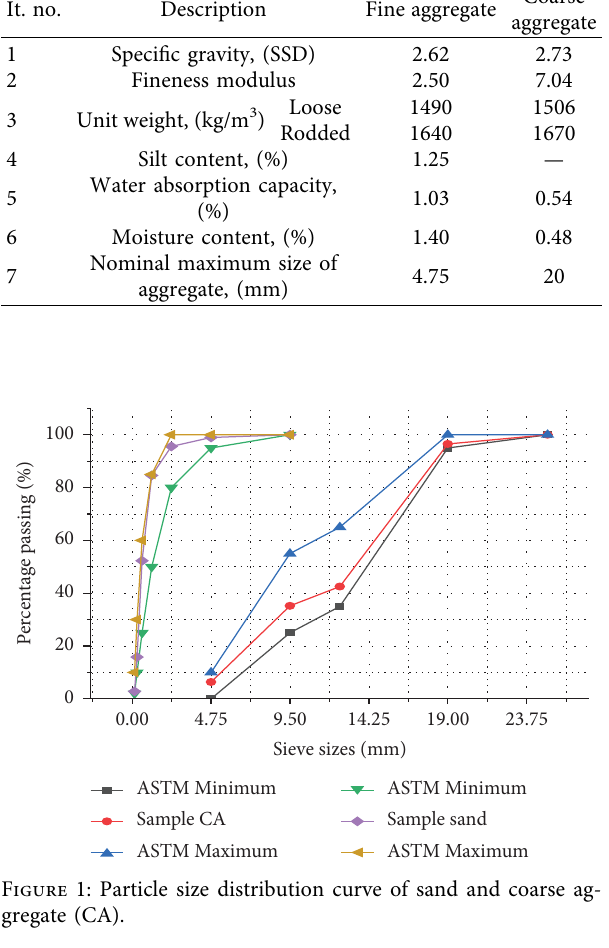
Table 1: Summary of physical properties of aggregates used. It. no.